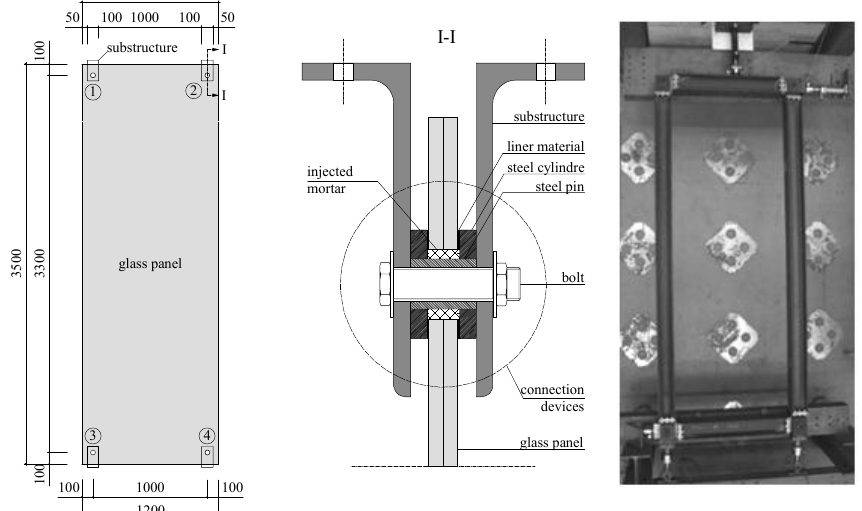
Figure 10: One-point supported panel test: specimen, substructures and testing frame [12]. The specimens were tested under displacement control with constant increments of 2.4 mm/min. The applied force F and the longitudinal displacement (consisting of glass plate elongation and deformation of the connection devices) were measured directly by the testing machine.